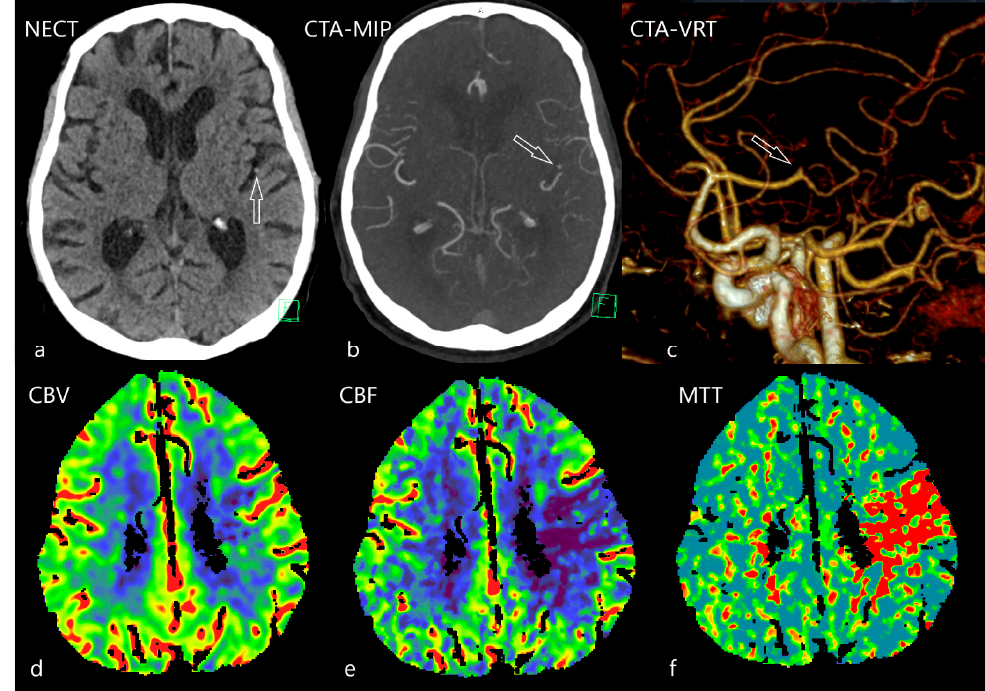
Figure 3. Distal medial cerebral artery occlusion by calcified embolus from mitral valve prosthesis endocarditis. 82-year-old male after mitral and tricuspid valves surgical replacement 11 years ago was admitted to emergency after the fall due to unconsciousness. He suffered from aphasia and the right sided hemiparesis; atrial fibrillation was revealed as well. On NECT ( a ) the small calcified dot was depicted in the Sylvian area (arrow), the same finding (arrow) was apparent on CTA with transversal maximum intensity projection (MIP) 3D reconstruction ( b ), the amputation of one of the arterial branches is seen on 3D volume rendering reconstruction (VRT) [( c ), arrow]. On CTP (lower row) a region of hypoperfusion is present ( e ), with prolonged mean transit time (MTT) [red area, ( f )] and decreased cerebral blood flow (CBF) [blue area, ( e )]; however, the cerebral blood volume (CBV) was not affected [blue area, ( d )]. Mitral valve prosthesis endocarditis was revealed as the probable source of emboli.